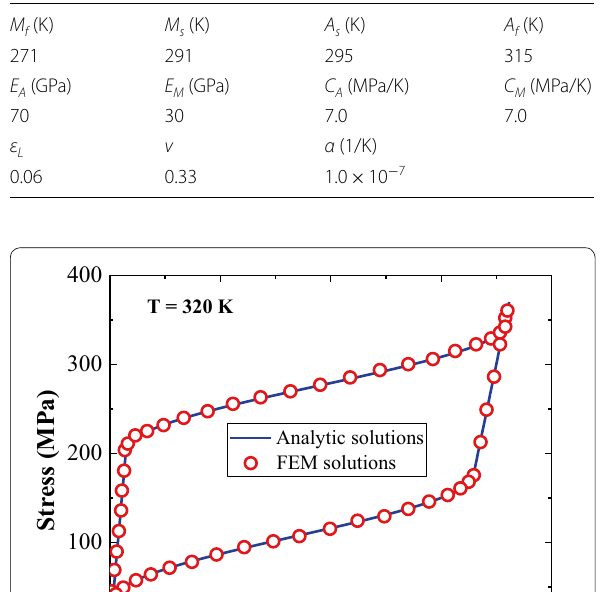
Table 1 Material parameters of SMA [23]